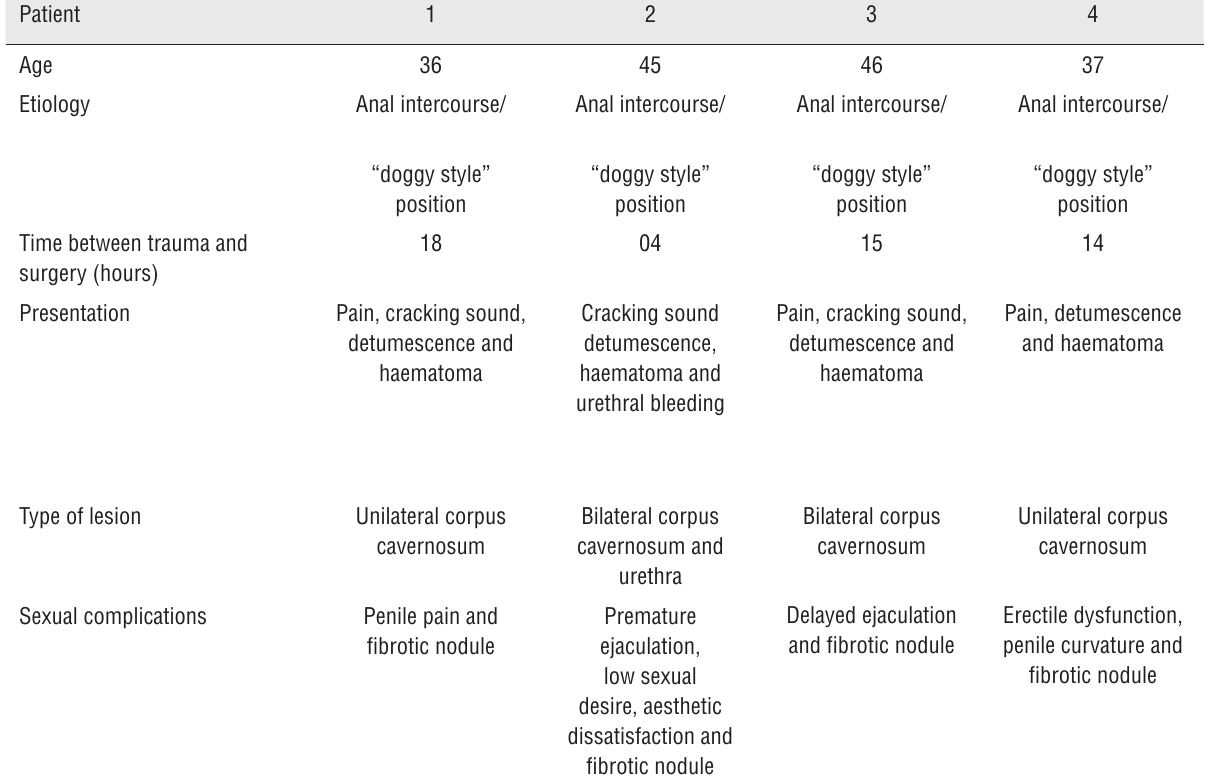
Table 1 – Demographic data, presentation, operative findings and sexual